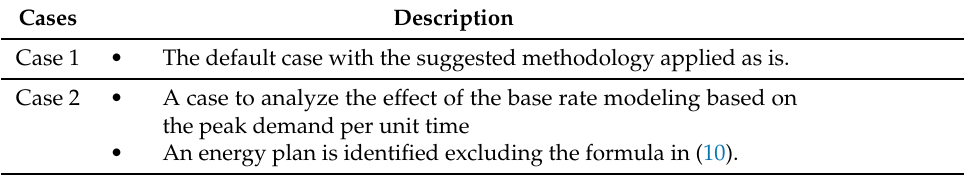
Table 9. Composition of the case